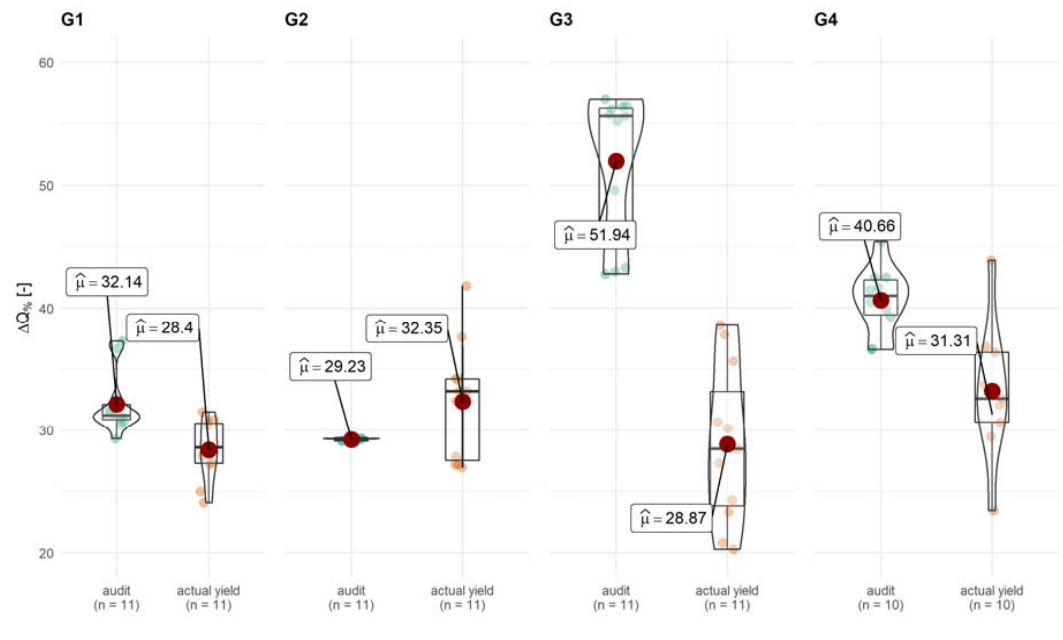
Figure 3. Comparison of the audit results with the actual decrease in energy consumption.